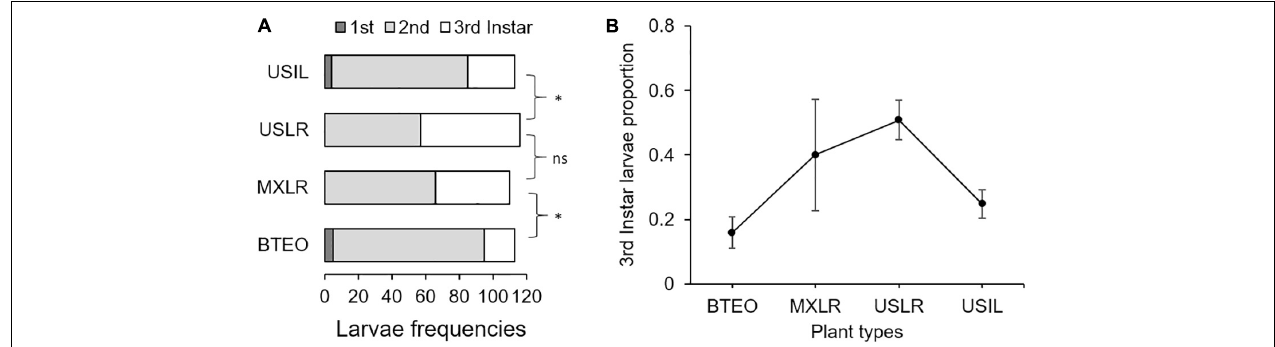
FIGURE 3 | (A) Frequency distributions of 1st-, 2nd-, and 3rd-instar larvae, and (B) development speed (=proportion of larvae reaching 3rd-instar) of larvae of Western corn rootworm in trials concluding 10 days after neonates were allowed to feed on one of four plant types. Plant types were Balsas teosintes (BTEO), Mexican maize landraces (MXLR), US maize landraces (USLR), and US inbred maize lines (USIL), and are ordered from most ancestral to most derived. A priori , pair-wise comparisons between frequency distributions representing the domestication (BTEO vs. MXLR) and breeding (USLR vs. USIL) transitions were significant (*G ≥ 17.25, P < 0.001), while the comparison representing the spread transition (MXLR vs. USLR) was not significant (G = 2.34, P = 0.309); the critical P -value for these comparisons was set at P ≤ 0.017, per Sidak’s correction. Univariate analysis of variance (ANOVA) indicated that development speed did not vary across plant types ( F 3 , 8 = 2.33, P = 0.150).